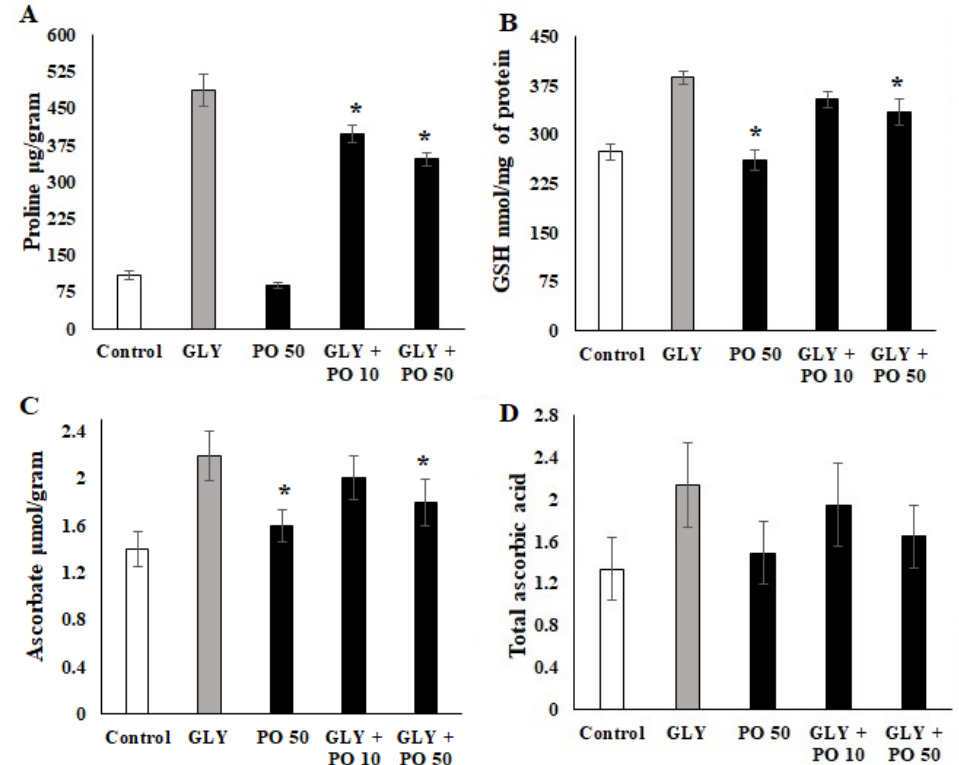
Figure 3. Tomato plants untreated (Control) or treated with GLY, PO 50, or a mix of both (GLY + PO 10; GLY + PO 50). ( A ) Proline, ( B ) GSH ( C ) Ascorbate and ( D ) Ascrobic Acid concentration. Data presented are mean ± SD ( n ≥ 4). * indicate significant statistical differences between treatments and GLY-treated plants (Tukey’s test: p ≤ 0.05). Black bars indicate the treatment with PO and GLY + PO, the grey bar indicate GLY treatment and the white bar indicates the untreated control.